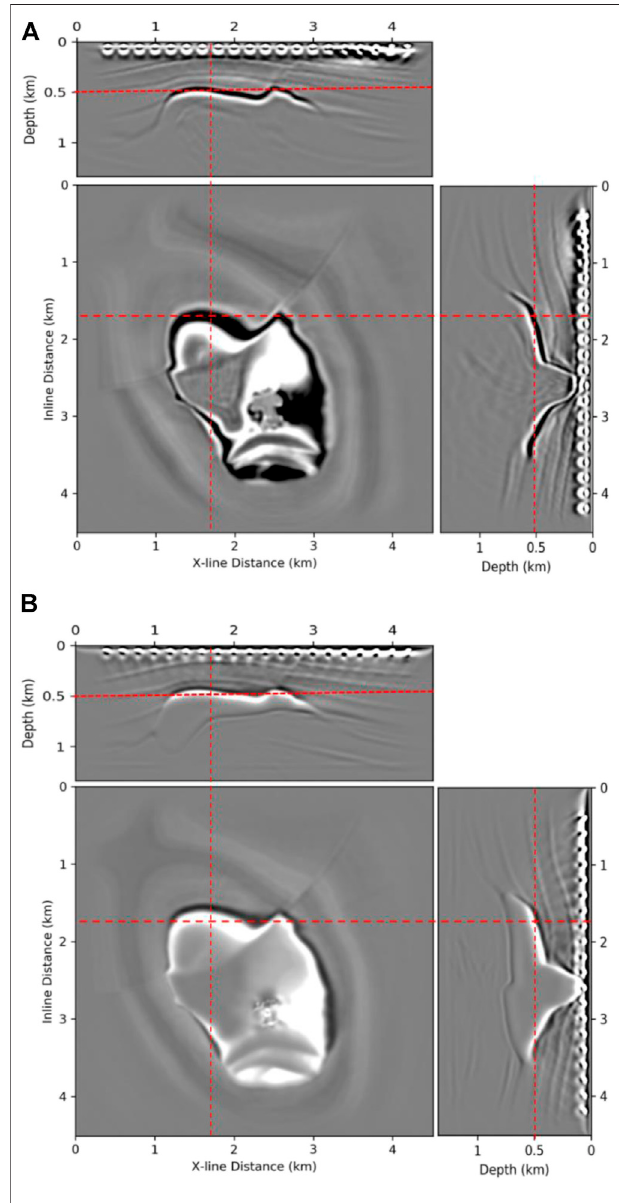
FIGURE 8 | Comparison of migration images between (A) smoothed linearly increasing velocity model and (B) smoothed true velocity